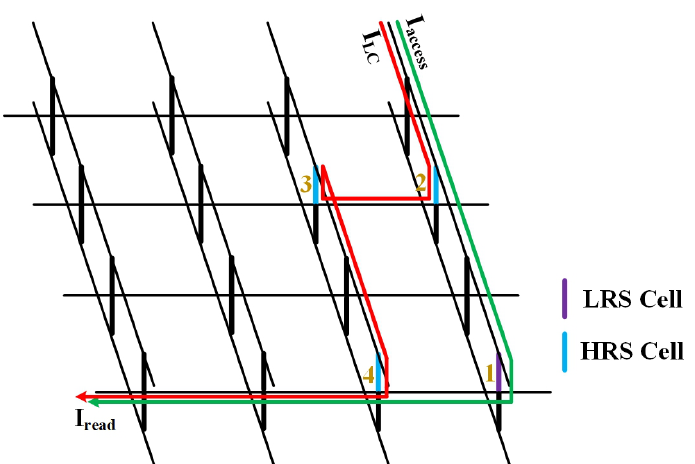
Figure 3. Sneak path in 3-D VRRAM